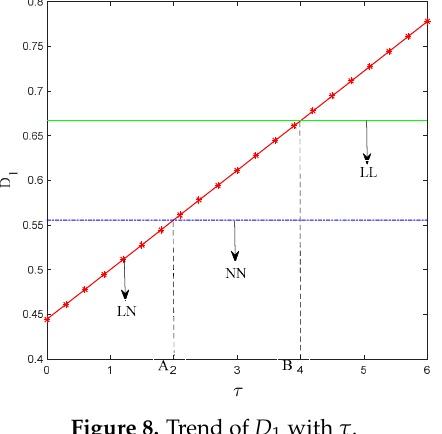
Figure 8. Trend of D 1 with τ .